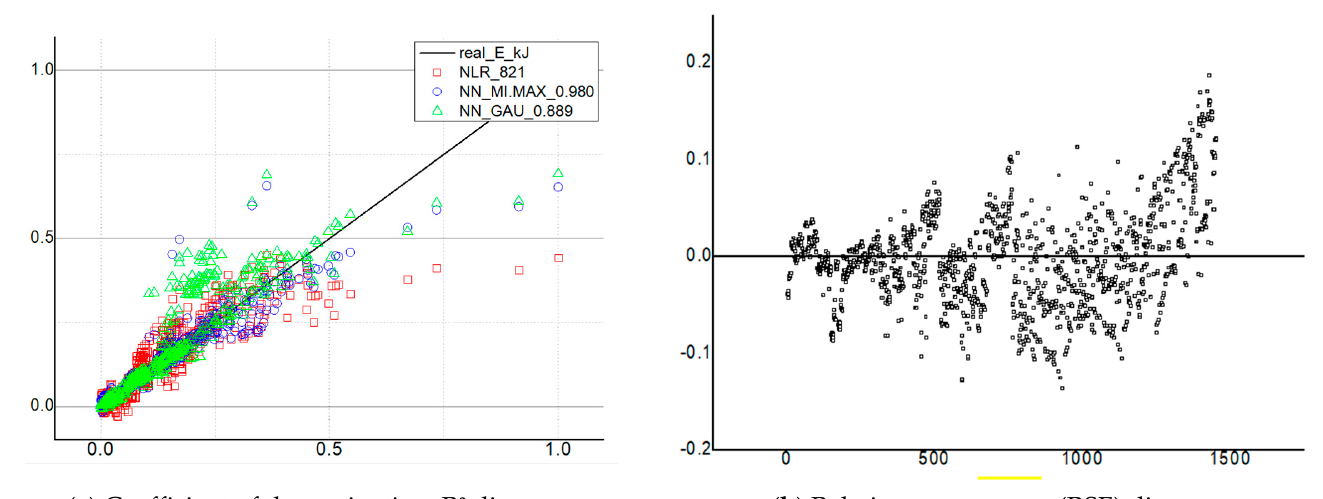
Figure 9. An R 2 comparison showing good NN–MM model performance and relative square error: ( a ) comparison of real data and predicted model R 2 values, ( b ) relative square error (RSE) for NN– MM model.